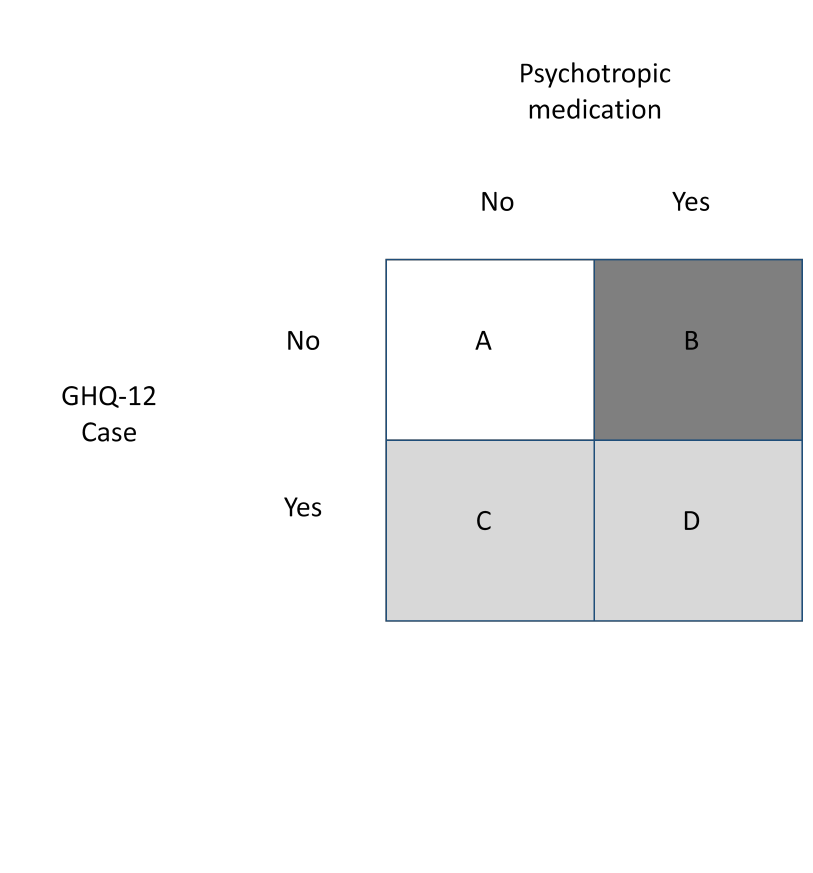
Figure 1: Relationship between GHQ-12 caseness and sDAS medication use